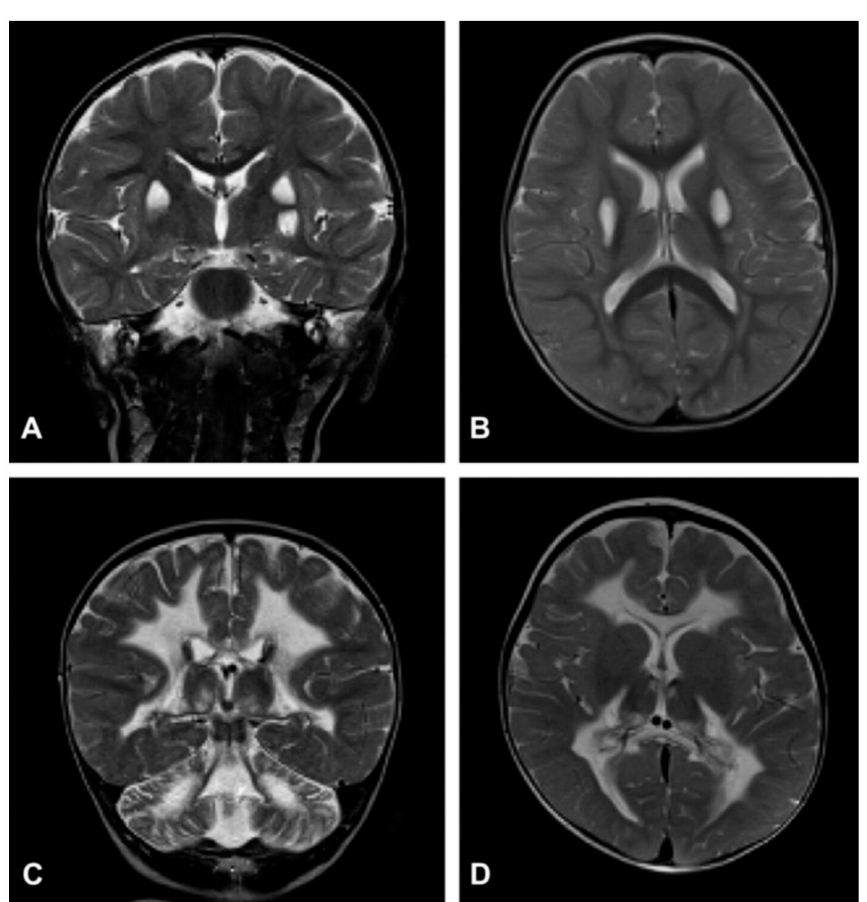
Figure 3. Neuroimaging in Leigh disease. ( A , B ) Magnetic resonance imaging (MRI) of patient presenting with Leigh phenotype with complex I deficiency due to m.10158T>C mutation in MTND3 gene: coronal ( A ) and axial ( B ) T2-weighted images show bilateral putaminal hyperintense lesions and minimal posterior periventricular white matter hyperintensity (B). ( C , D ) MRI of patient presenting with mitochondrial leukoencephalopathy with complex II deficiency due to mutation p.Gly169Cys of SDHAF1 gene: coronal ( C ) and axial ( D ) T2-weighted images show hyperintensity of the lobar white matter also involving the corpus callosum and the posterior arms of the internal capsule ( D ); the white matter is abnormal also in the cerebellar hemispheres ( C ). Adapted from: